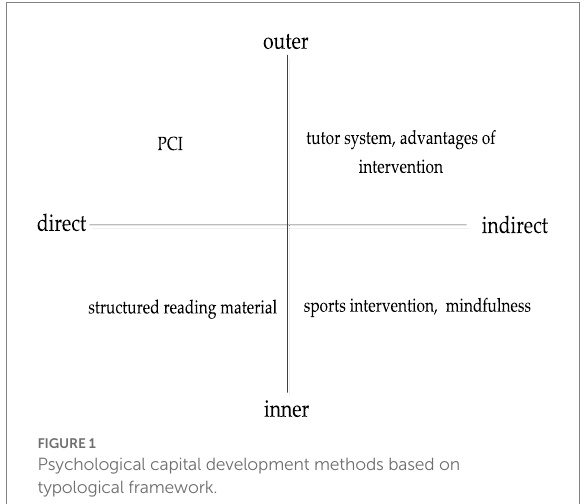
FIGURE 1 Psychological capital development methods based on typological